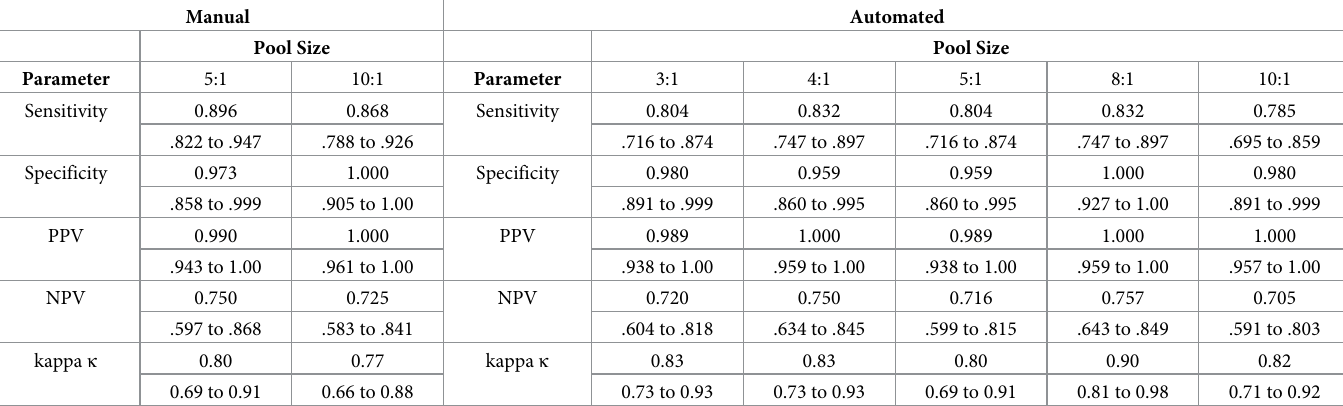
Table 5. Aptima 1 performance